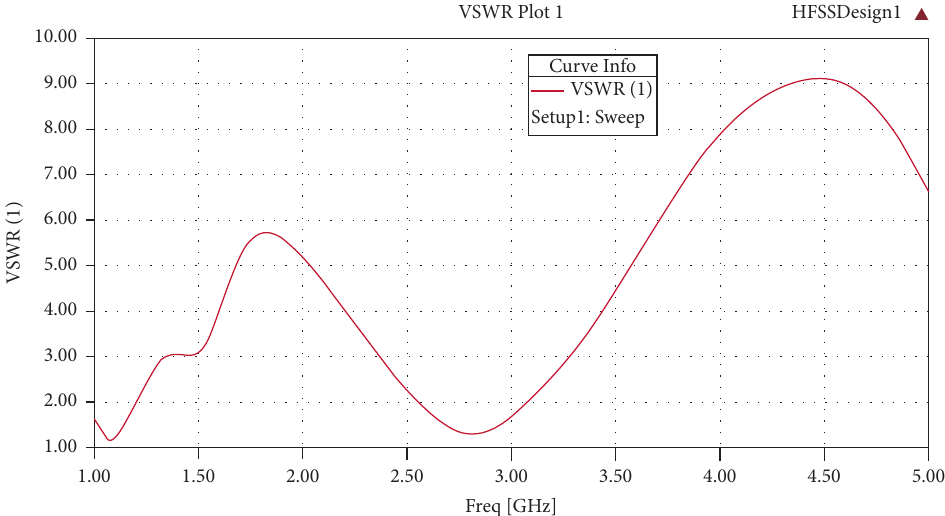
Figure 5: VSWR coefficient of the proposed design.